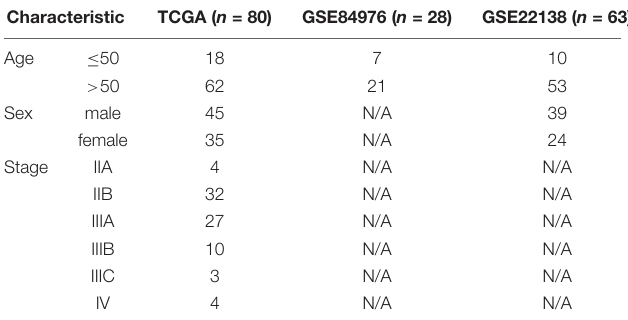
TABLE 1 | Clinical characteristics of patients in the